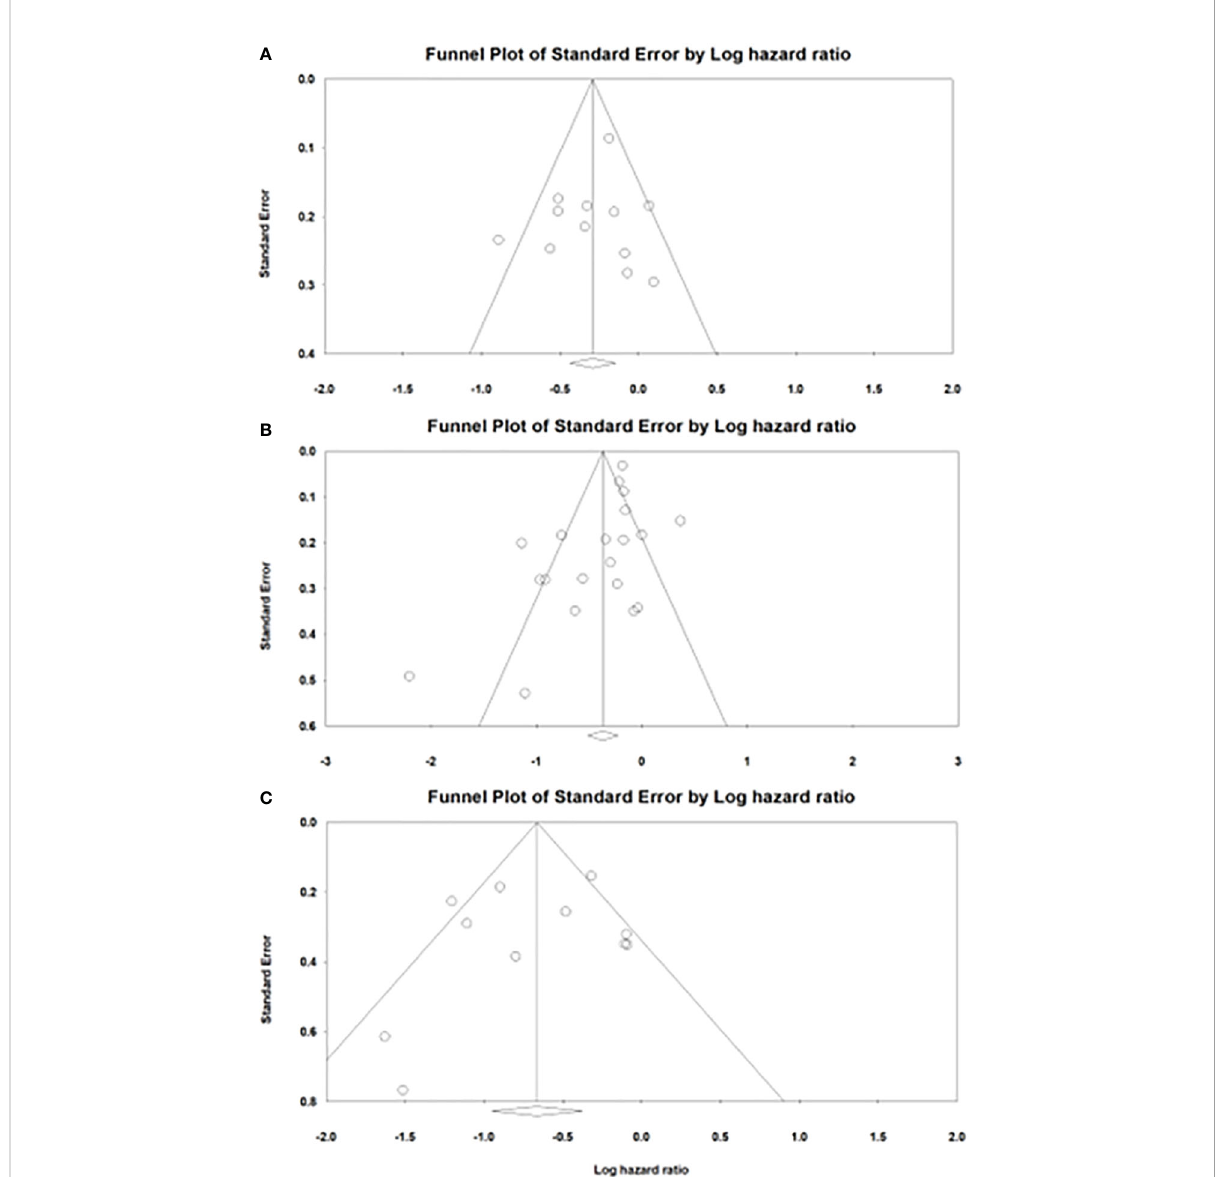
FIGURE 3 Funnel plots of publication bias in analysis of (A) post progression progression-free survival. (B) post progression overall survival. (C) overall survival from initiation of